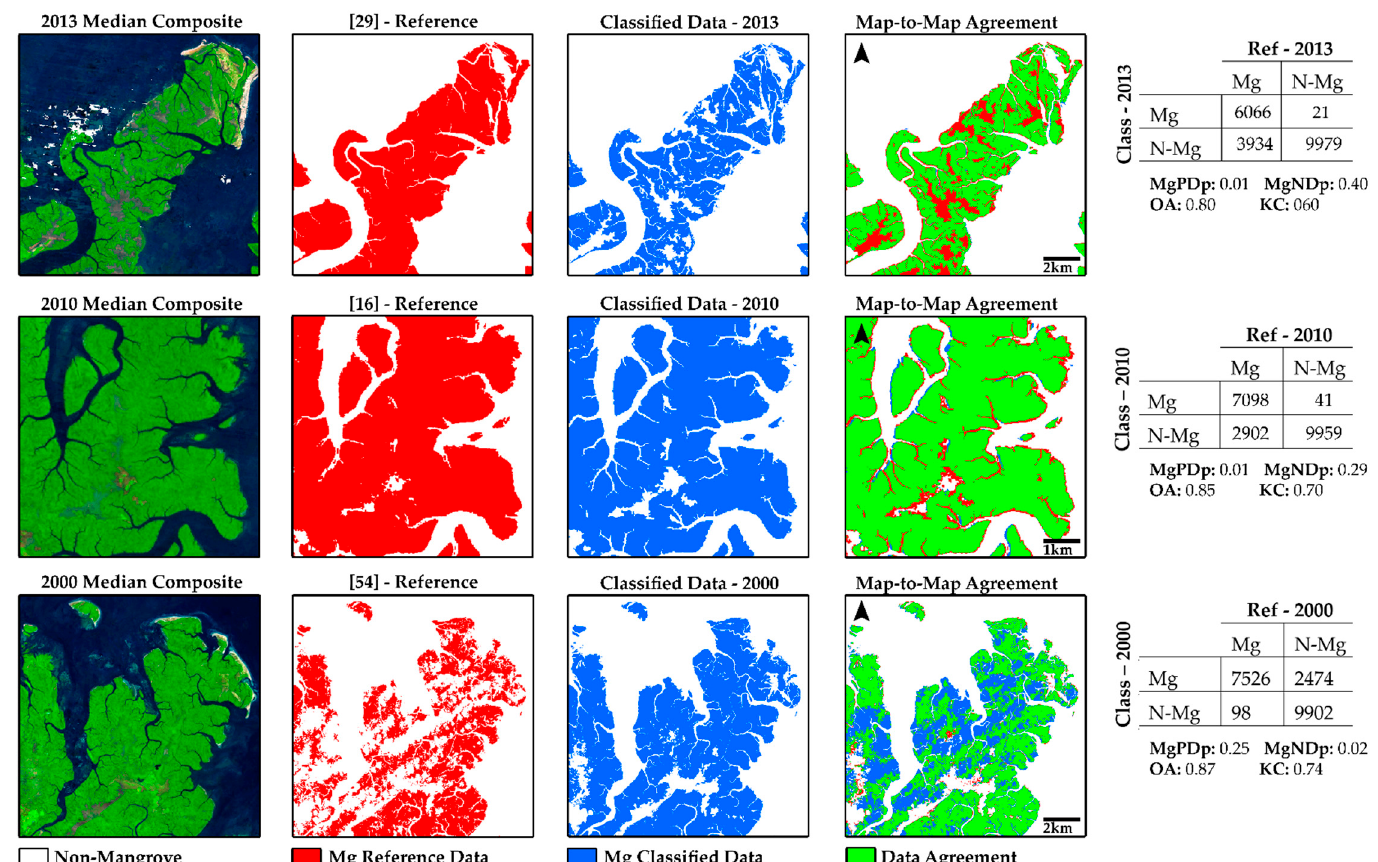
Figure 11. On the left are the 2000, 2010 and 2013 median composites. In the central portion, red represents the mangroves of the reference data, blue denotes the classified mangroves and green represents the agreement between blues and reds. The contingency tables (right) show the agreement levels between the reference and classified data. Values on the main diagonal are the numbers of concordant pixels. On the off-diagonal, those above are positive differences and those below are negative differences. OA stands for overall agreement, MgPDp means the mangrove positive disagreement proportion, MgNDp refers to the mangrove negative disagreement proportion and KC denotes the kappa coefficient.